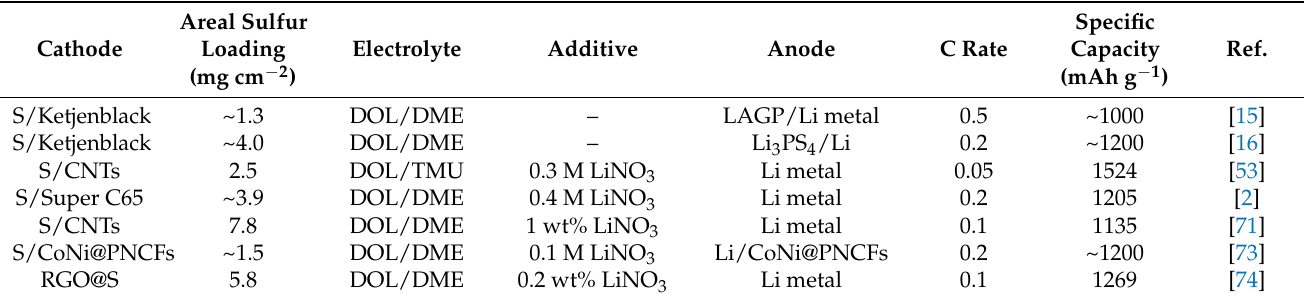
Table 3. Electrochemical performance of Li–S pouch cells with liquid